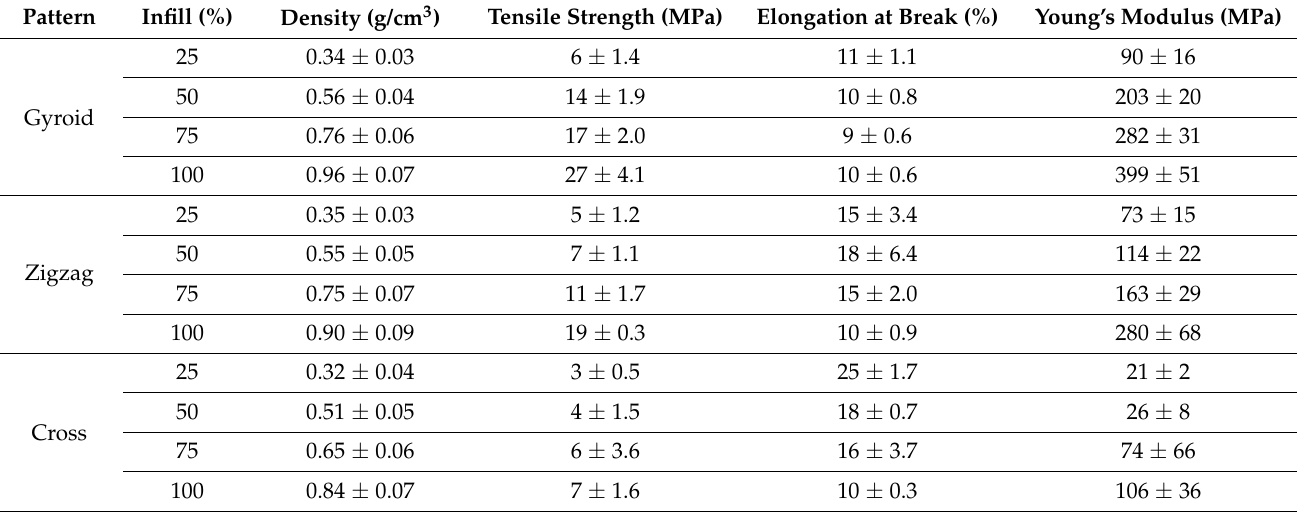
Table 1. Density and engineering constants of carbon–PLA